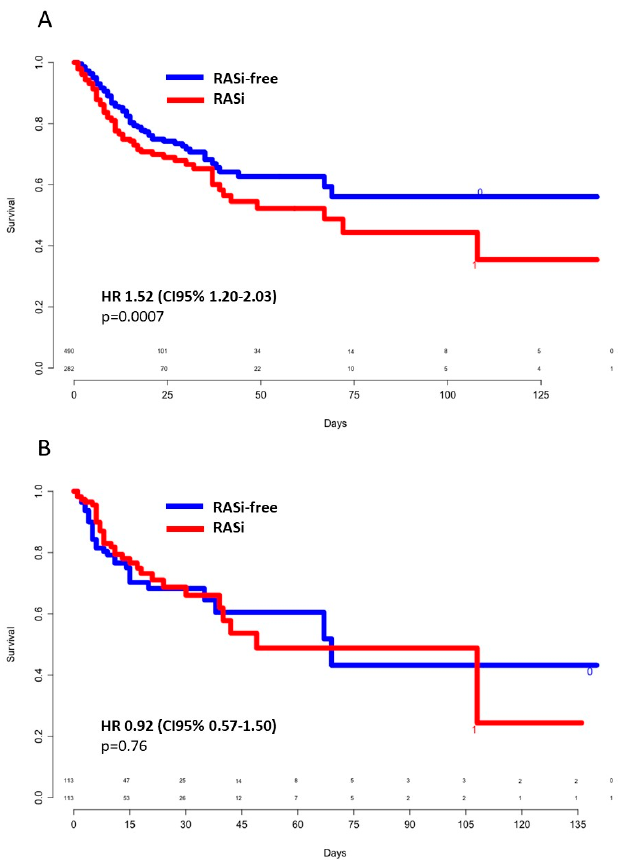
Figure 2. Crude ( A ) and propensity score-weighted ( B ) survival according to previous RASi use. CI: Confidence interval; HR: Hazard ratio; RASi: Renin–angiotensin system inhibitors.